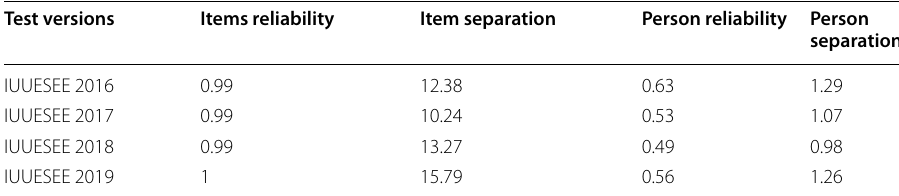
Table 2 Results of Rasch reliability